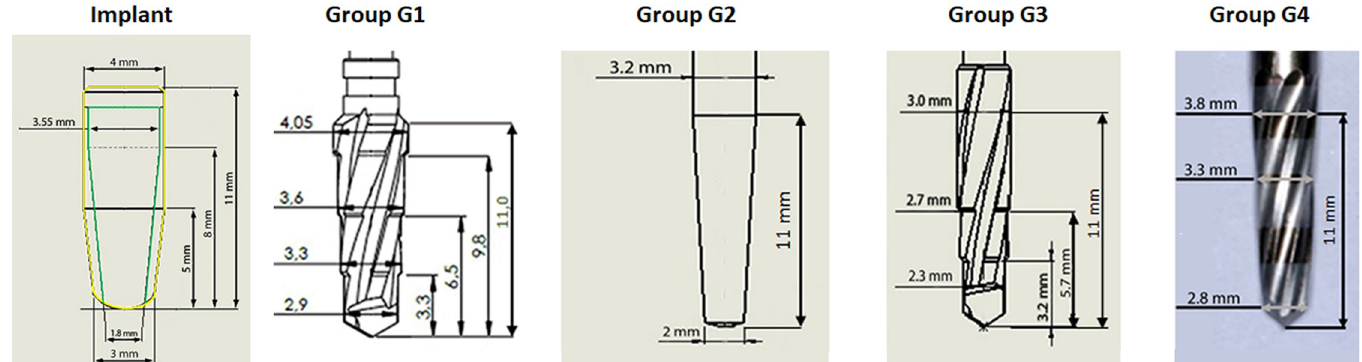
Fig 3. Image of the dimensions of each part used in the study. The green line corresponds to the implant body without the threads, and the yellow line corresponds to the external limits of the implant with the threads.